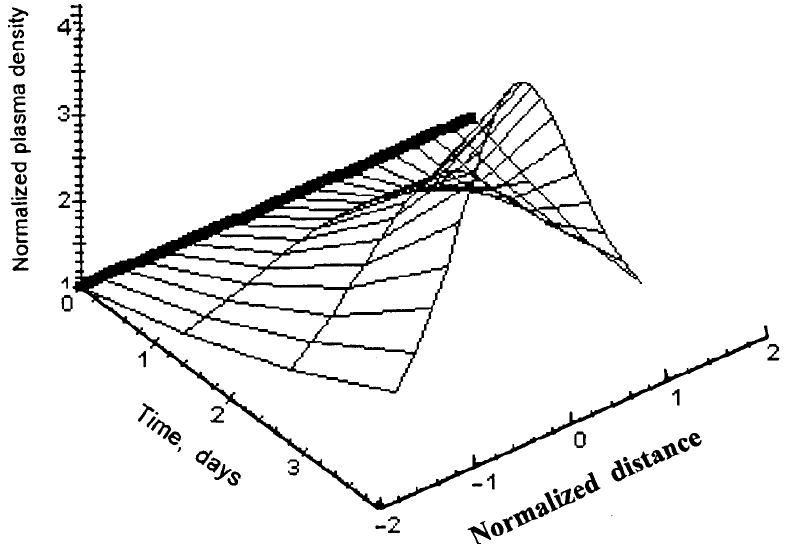
Fig. 4. Same as in Fig. 3 but for a quasi 5-day PW having a typical cy- clonic scale size λ υ ∼ 15 × 10 3 km and a wave amplitude U = 15m/s. As seen, after about 2.5 days, the metallic ion plasma density in the central vortex areas increases near 3 times the back- ground